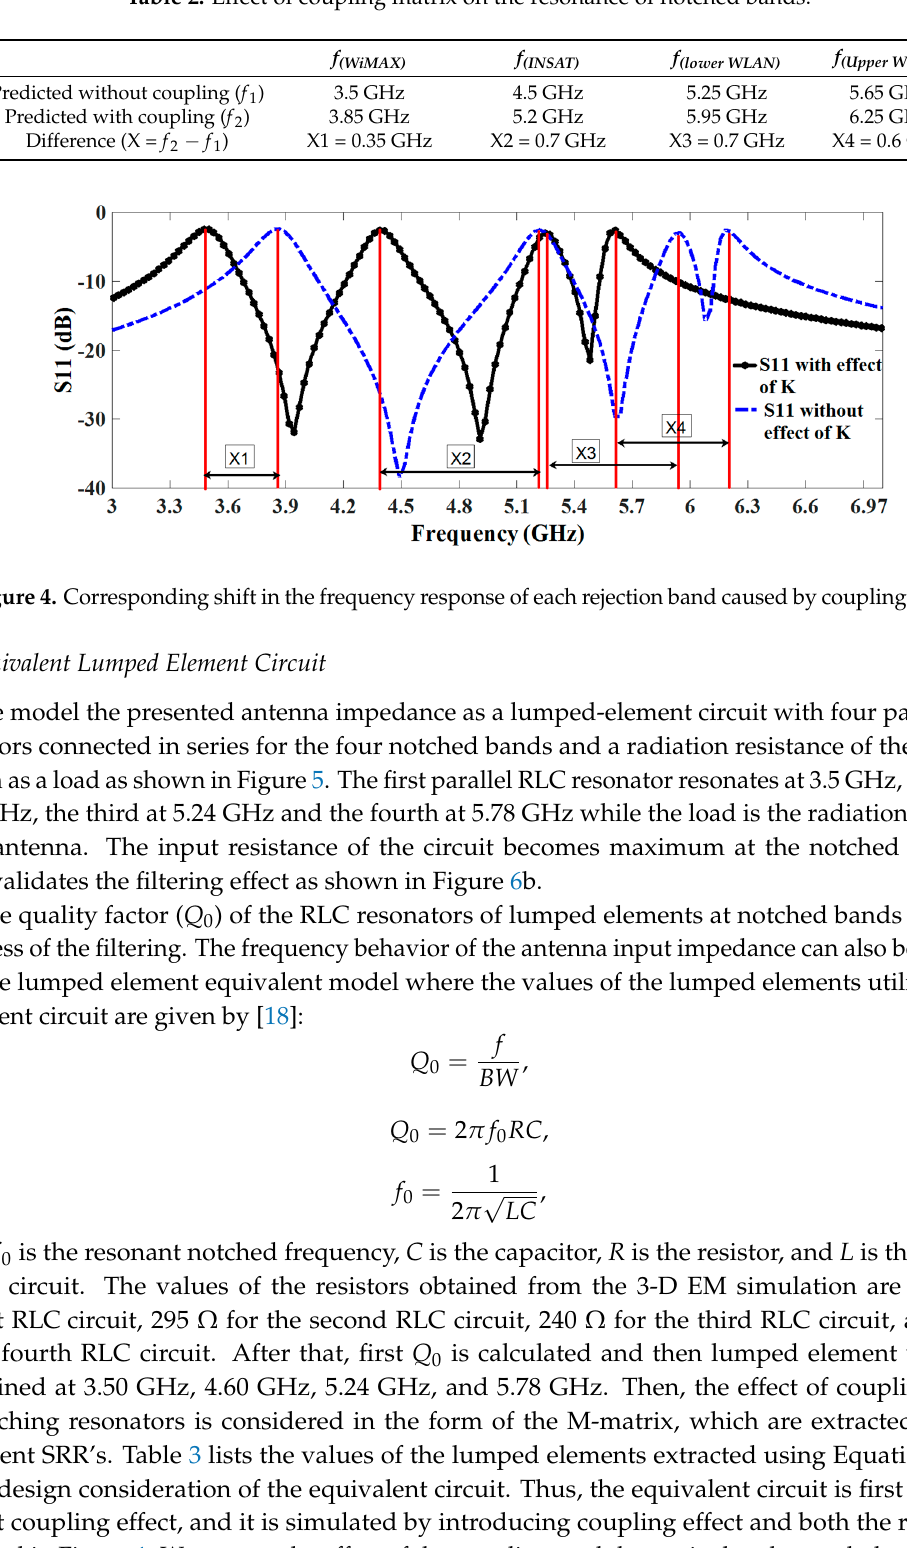
Table 2. Effect of coupling matrix on the resonance of notched bands.